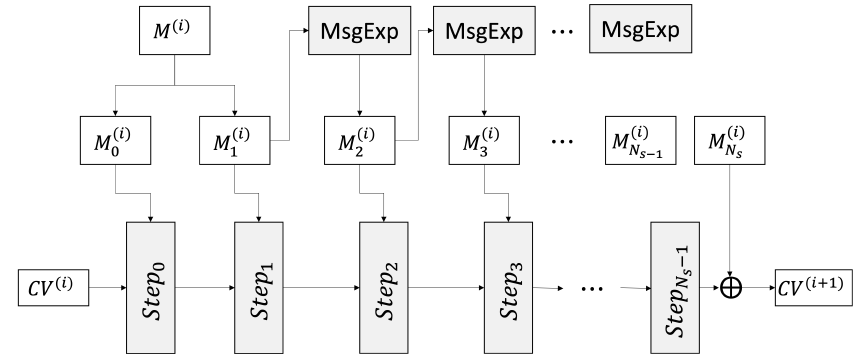
Figure 7. LSH quantum circuit for MsgExp and step